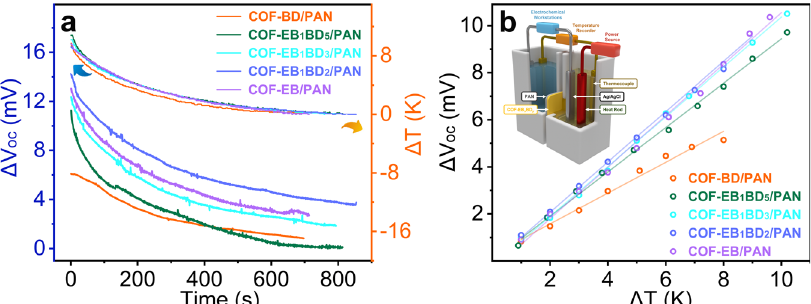
Fig. 5 Evaluation of thermoelectric response. a The synchronous time evolution of Δ V oc in response to the solution temperature changes ( 4 T , the overlapped curves above the orange arrow) for COF-EB x BD y /PAN in the presence of symmetric KCl solutions. b Linear fi ts of Δ V oc versus 4 T ; all the fi ts have R 2 values higher than 0.98 (inset: schematic illustration of the experimental setup used for investigating the thermoelectric response of COF-EB x BD y